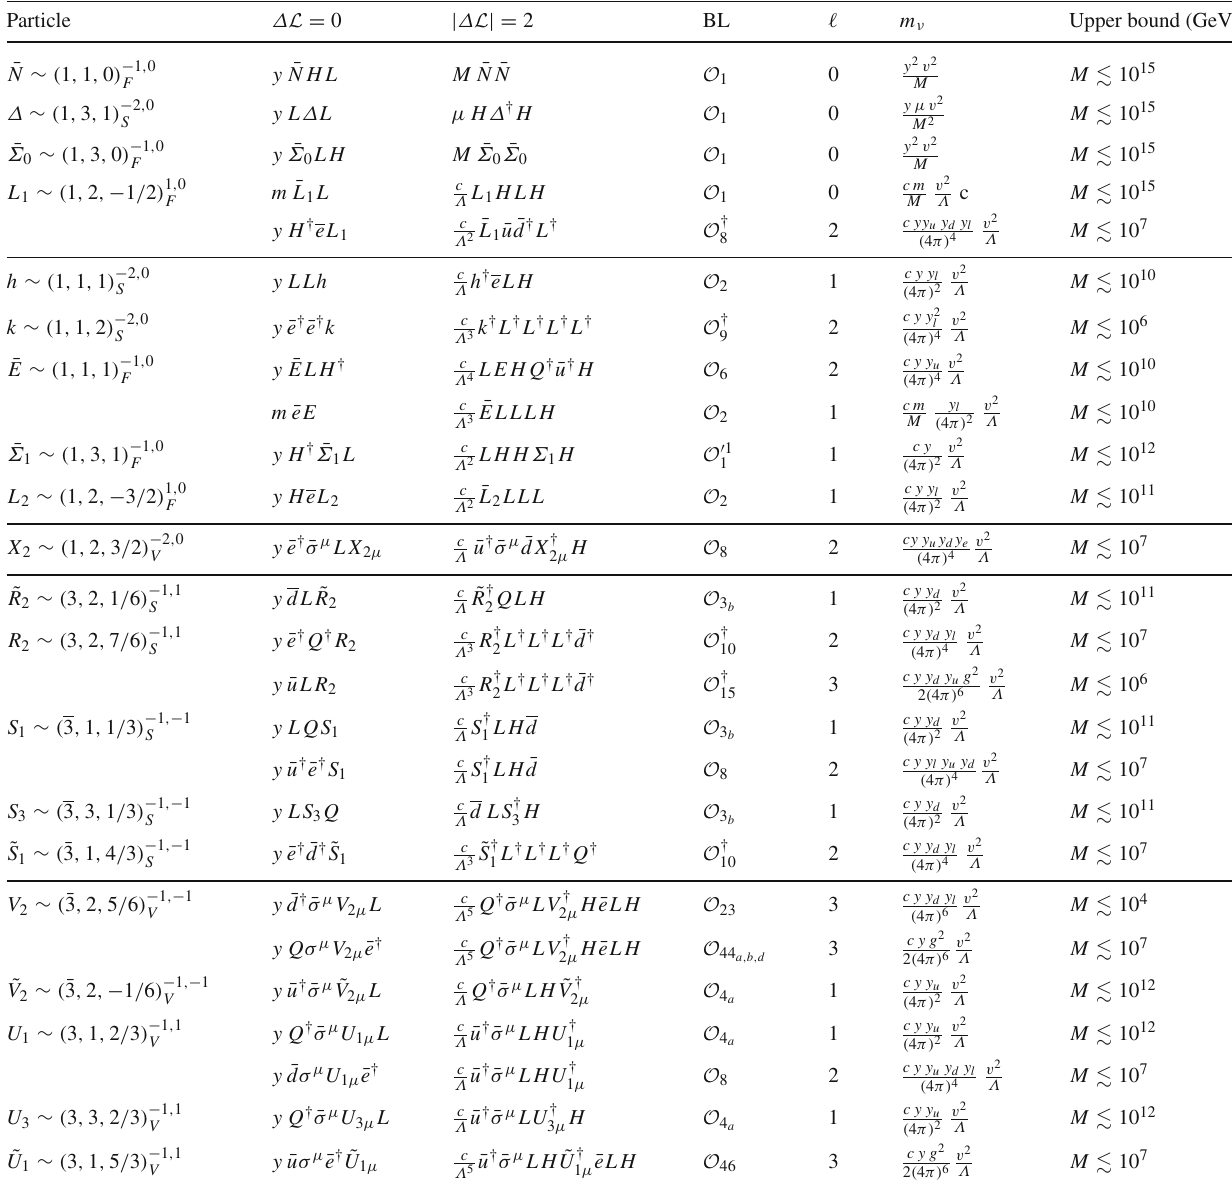
Table1 Particleswithquantumnumbers ( SU ( 3 ) c , SU ( 2 ) L , U ( 1 ) Y ) L , 3 B that couple to SM leptons at the renormalizable level, where P = F , S , V denotes whether it is a fermion, scalar or vector. Fermions are 2-component Weyl fermions. The corresponding Dirac partner is denoted by a bar on top of the same symbol. The interaction with leptons is shown in the second column. We do not show the SU(2) contractions. In order to obtain a conservative upper bound for the mass M , we choose the lowest-dimensional and simplest Δ L = 2 operator (third column). After integrating out the particle, the operator